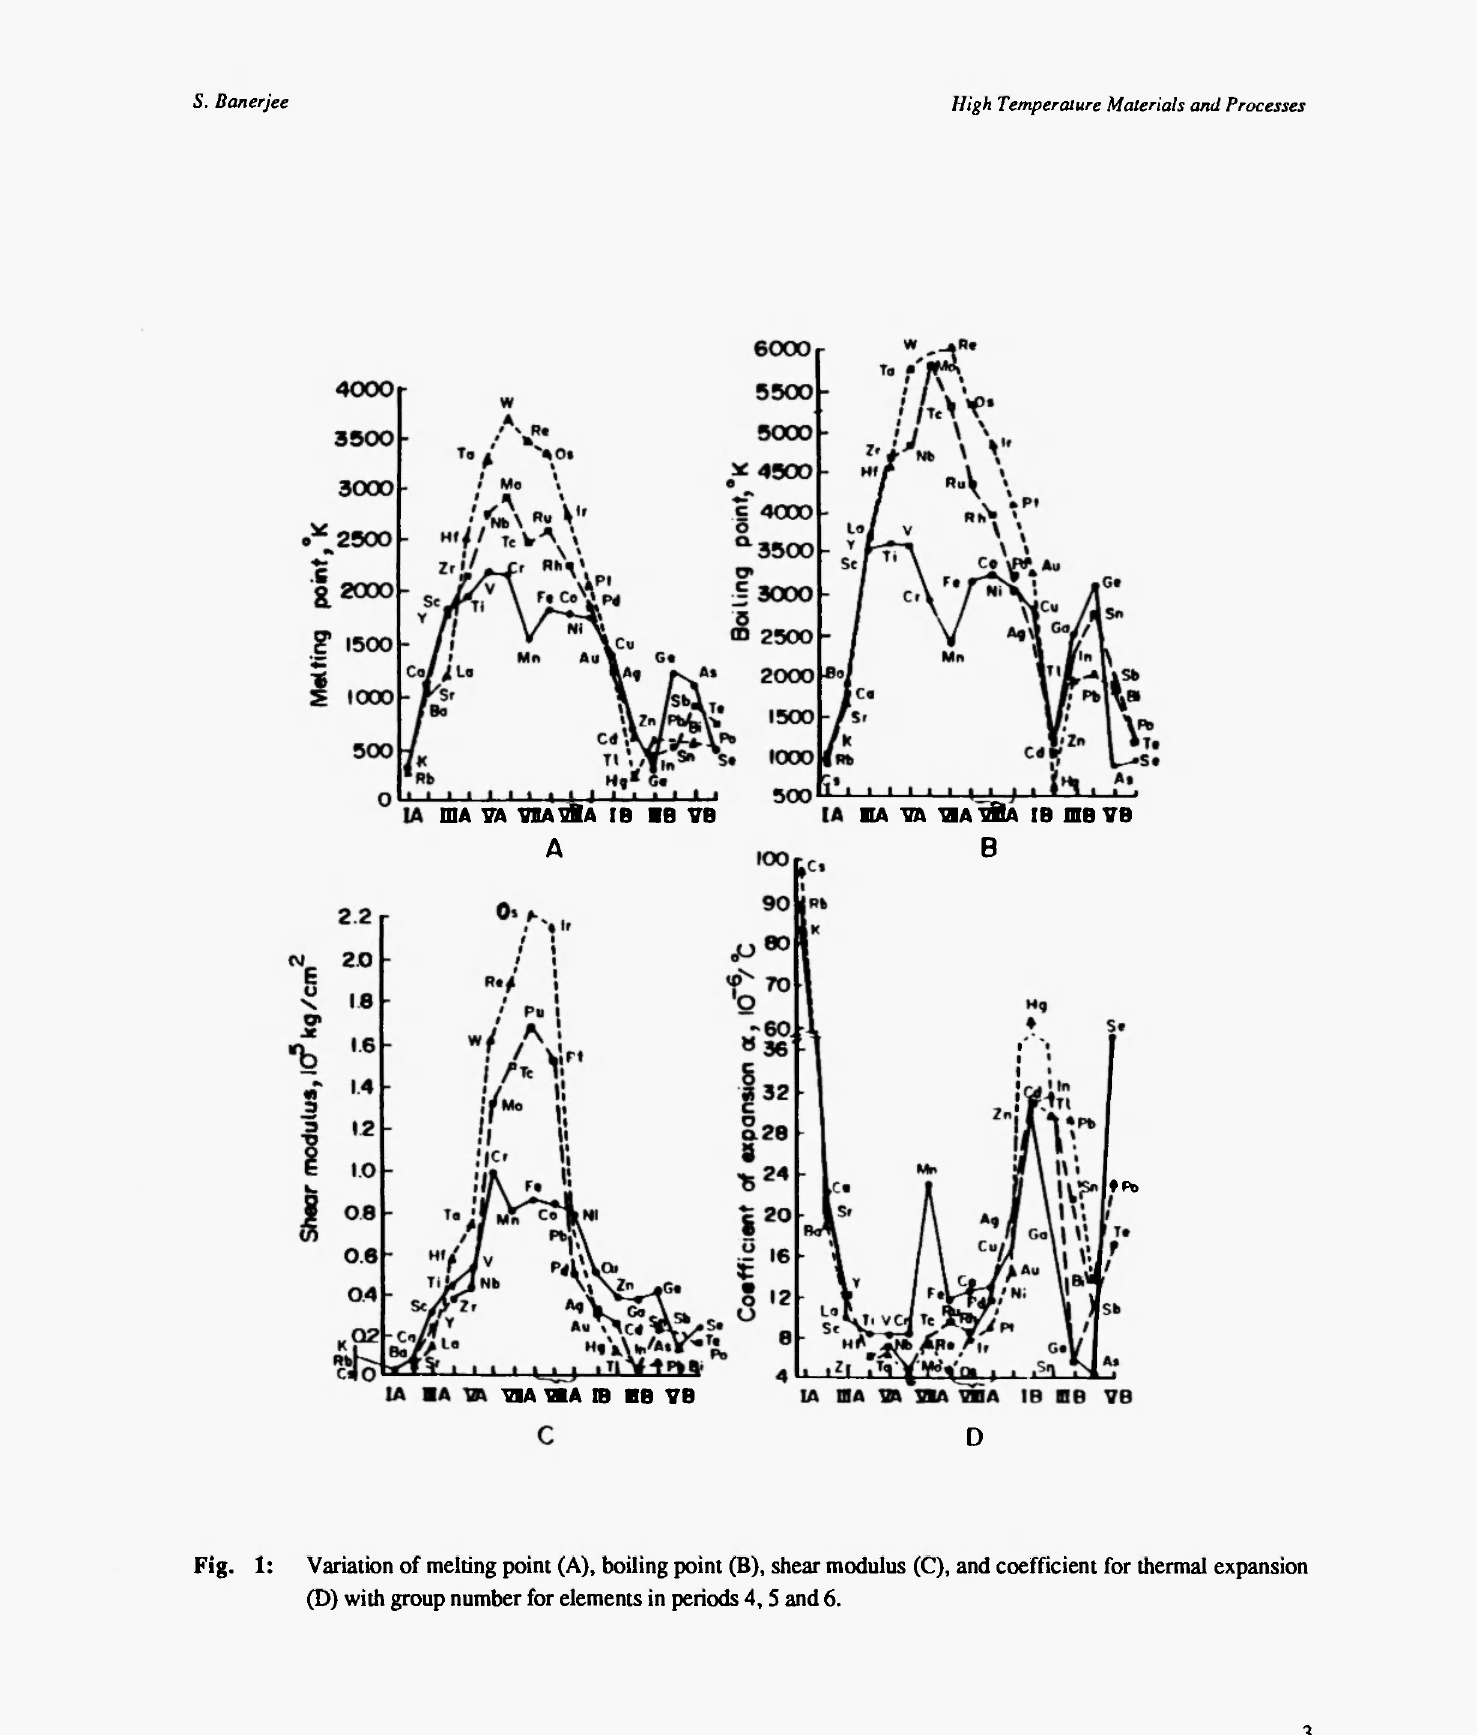
Fig. 1: Variation of melting point (A), boiling point (B), shear modulus (C), and coefficient for thermal expansion (D) with group number for elements in periods 4,5 and